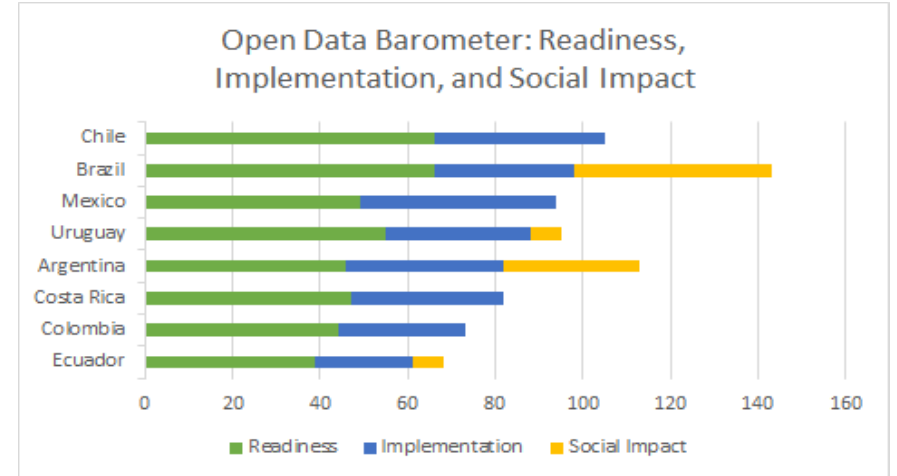
Figure 1: Latin American Cases and ODB